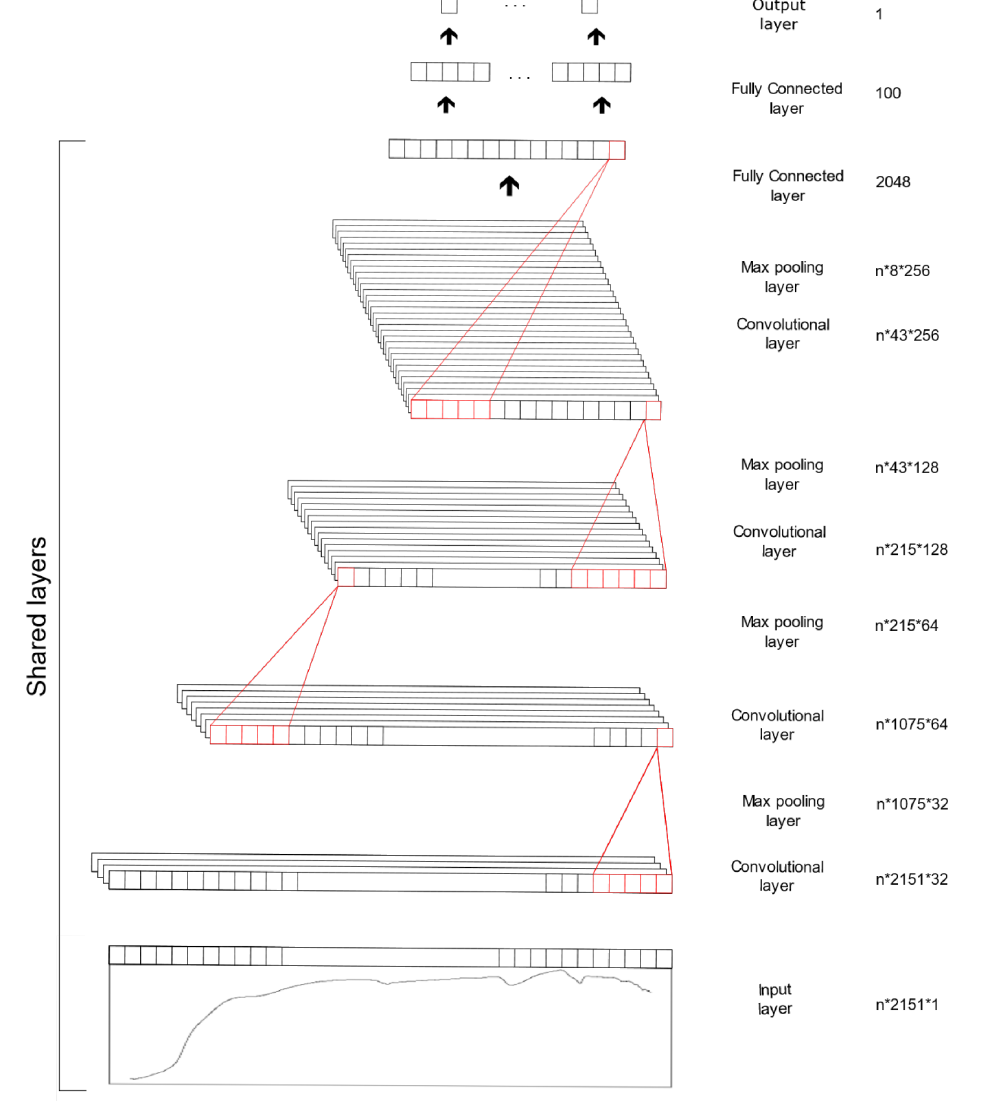
Figure 2. Architecture of the 1D convolutional neural network (CNN)